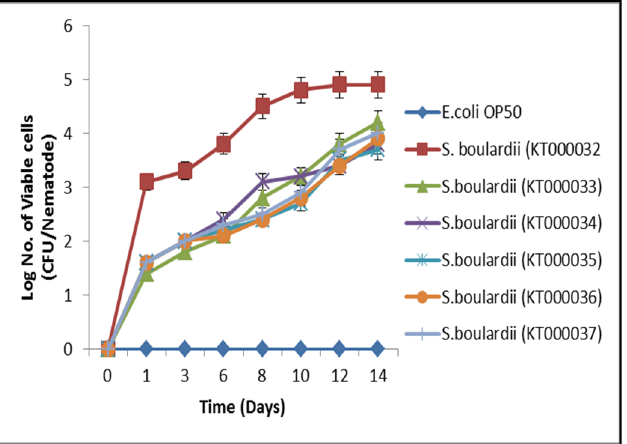
Figure 2. Bacterial colonization ability in C. elegans . The data points represent average CFU from five worms ± standard deviation of three independent experiments.